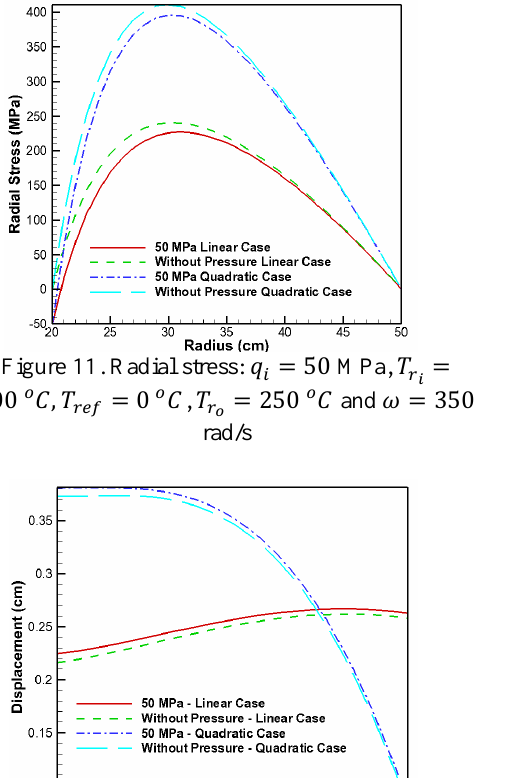
Figure 11. Radial stress: 𝑞 500 𝑜 𝐶, 𝑇 = 0 𝑜 𝐶 , 𝑇 𝑟𝑒𝑓